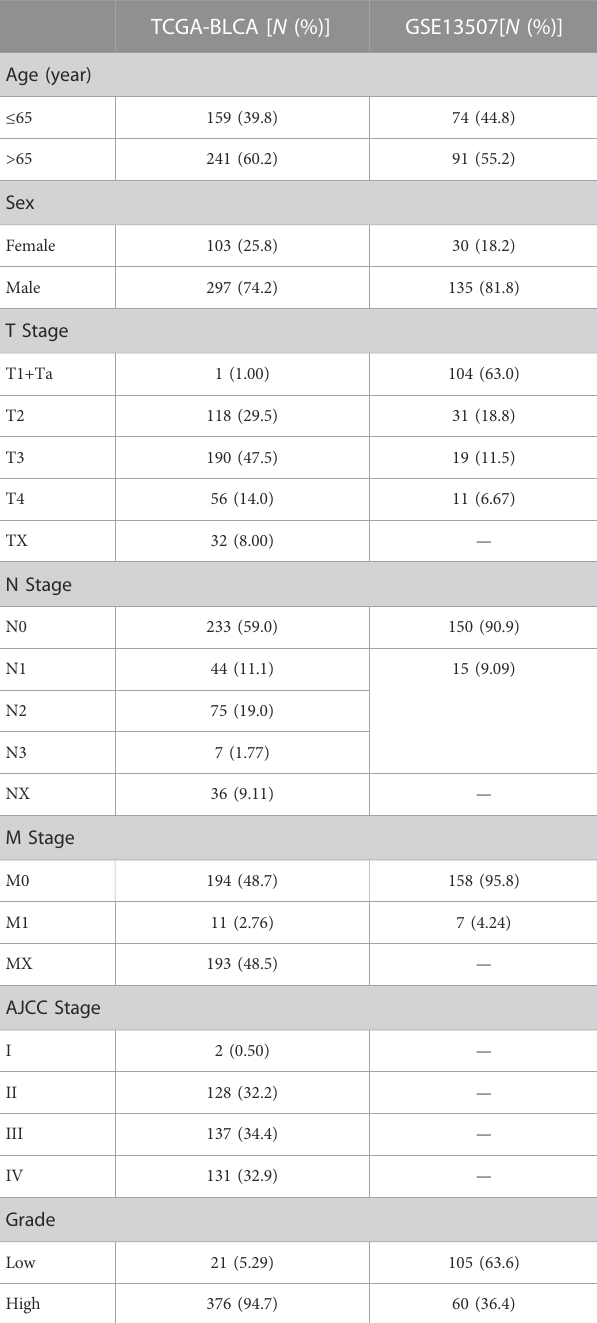
TABLE3Baselinetableof35patientswithbladdercancerintheDepartmentof Urology, Shantou Central